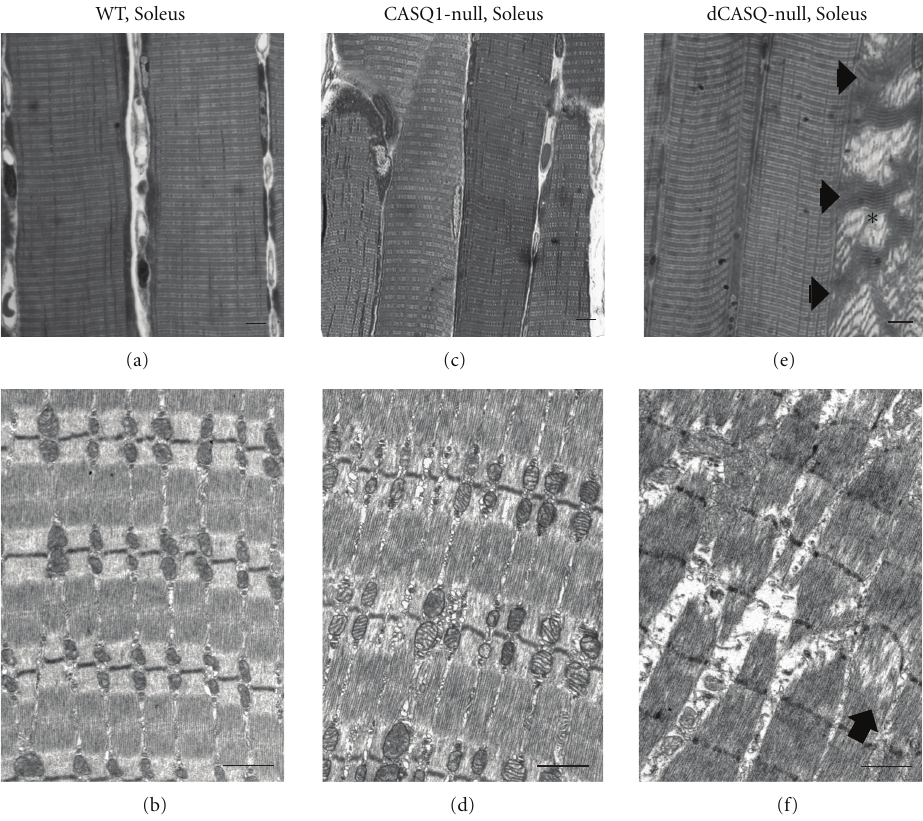
Figure 4: In dCASQ-null animals (4–6 months of age) ∼ 30% of Soleus fibers presented severe structural damage. (a), (c), and (e): histology; (b), (d), and (f): EM. (a) and (b) WT Soleus fibers from adult mice (4–6 months of age) always showed a well-defined cross-striation and well-organized EC coupling (not shown) and mitochondrial apparatus. (c)–(f) At 4–6 months of age, ∼ 30% of Soleus fibers (see Table 1) from dCASQ-null mice were a ff ected by severe structural alterations, which were clearly visible both at the histological examination (e) and in EM (f). In (e) arrowheads point to three contracture cores within the same severely damaged fiber (asterisk), while in (f) is shown a small portion of a fiber presenting degeneration of the contractile elements and initial Z line streaming (arrow). Fibers with similar alterations are very rare in CASQ1-null fibers ((c) and (d)) and never seen in WT. See Table 1 for quantitative analysis.